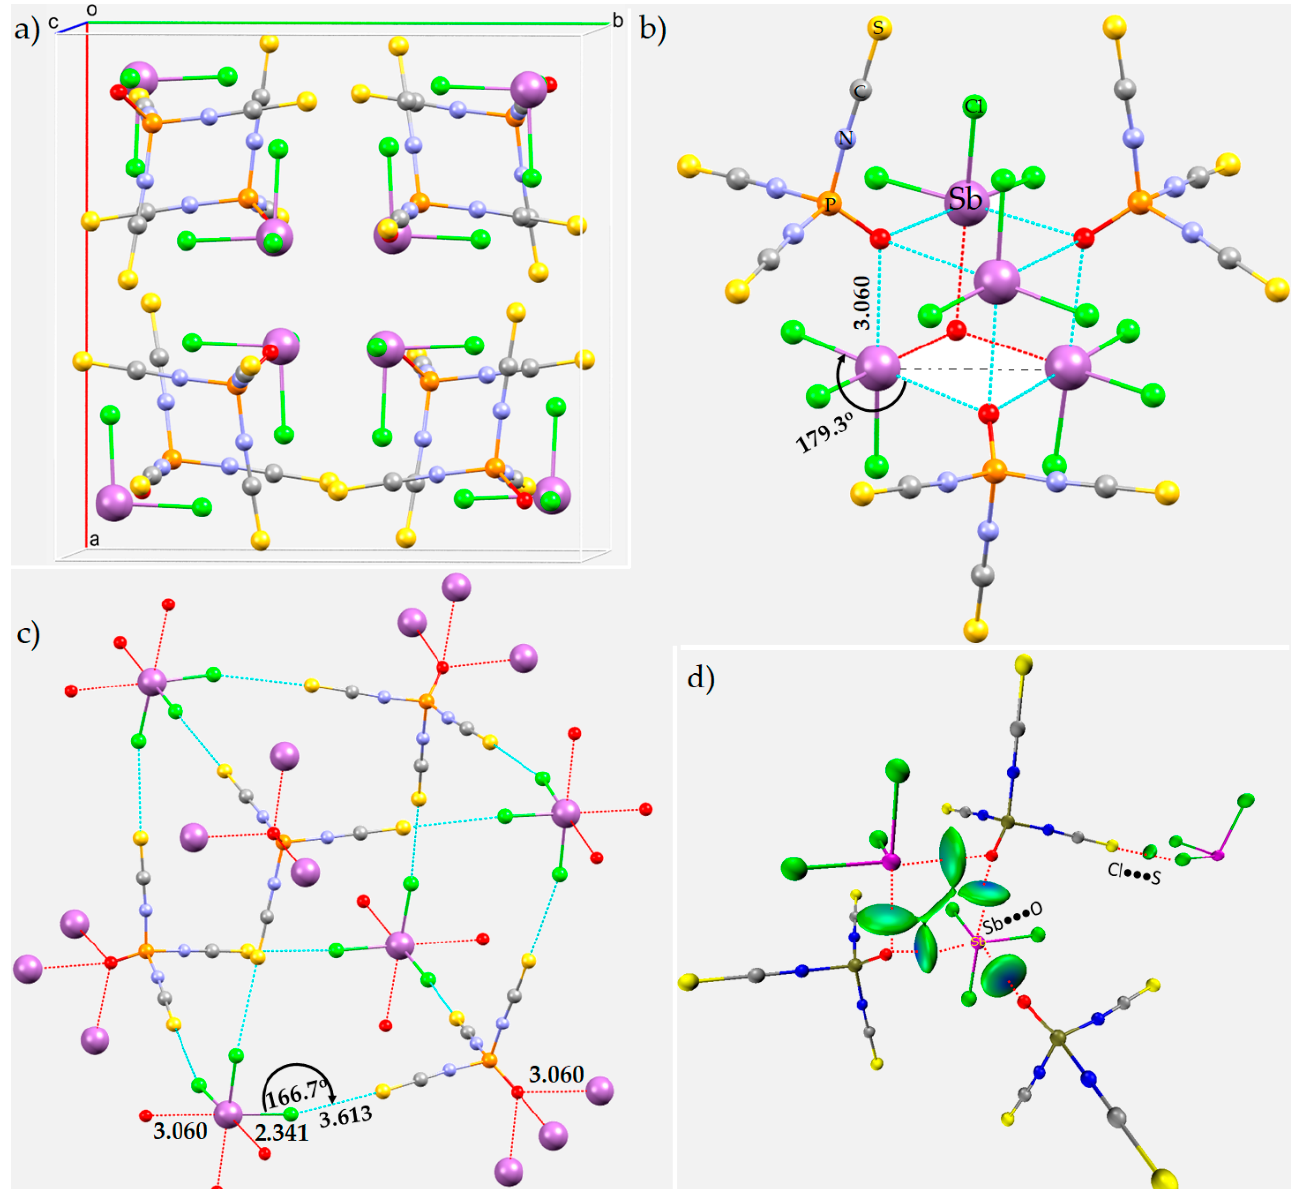
Figure 18. ( a ) The unit-cell of crystalline [SbCl 3 ·OP(NCS) 3 ] 4 (ICSD ref. code 80097). ( b ) The nature of the pseudo-octahedral coordination environment around the Sb center. ( c ) The Cl···S intermolecular interactions responsible for the pseudo 3D geometry of the crystalline material. ( d ) The IGM- δ g based isosurface topologies (isovalue = 0.008 a.u.) between OP(NCS) 3 and SbCl 3 . Bond distances and bond angles are in Å and degree, respectively. Hanging contacts in ( b , c ) in red represent coordinate bonds/intermolecular interaction. Atoms are shown as small spheres and bonds as lines in atom color, whereas the intermolecular interactions are represented by dotted lines.